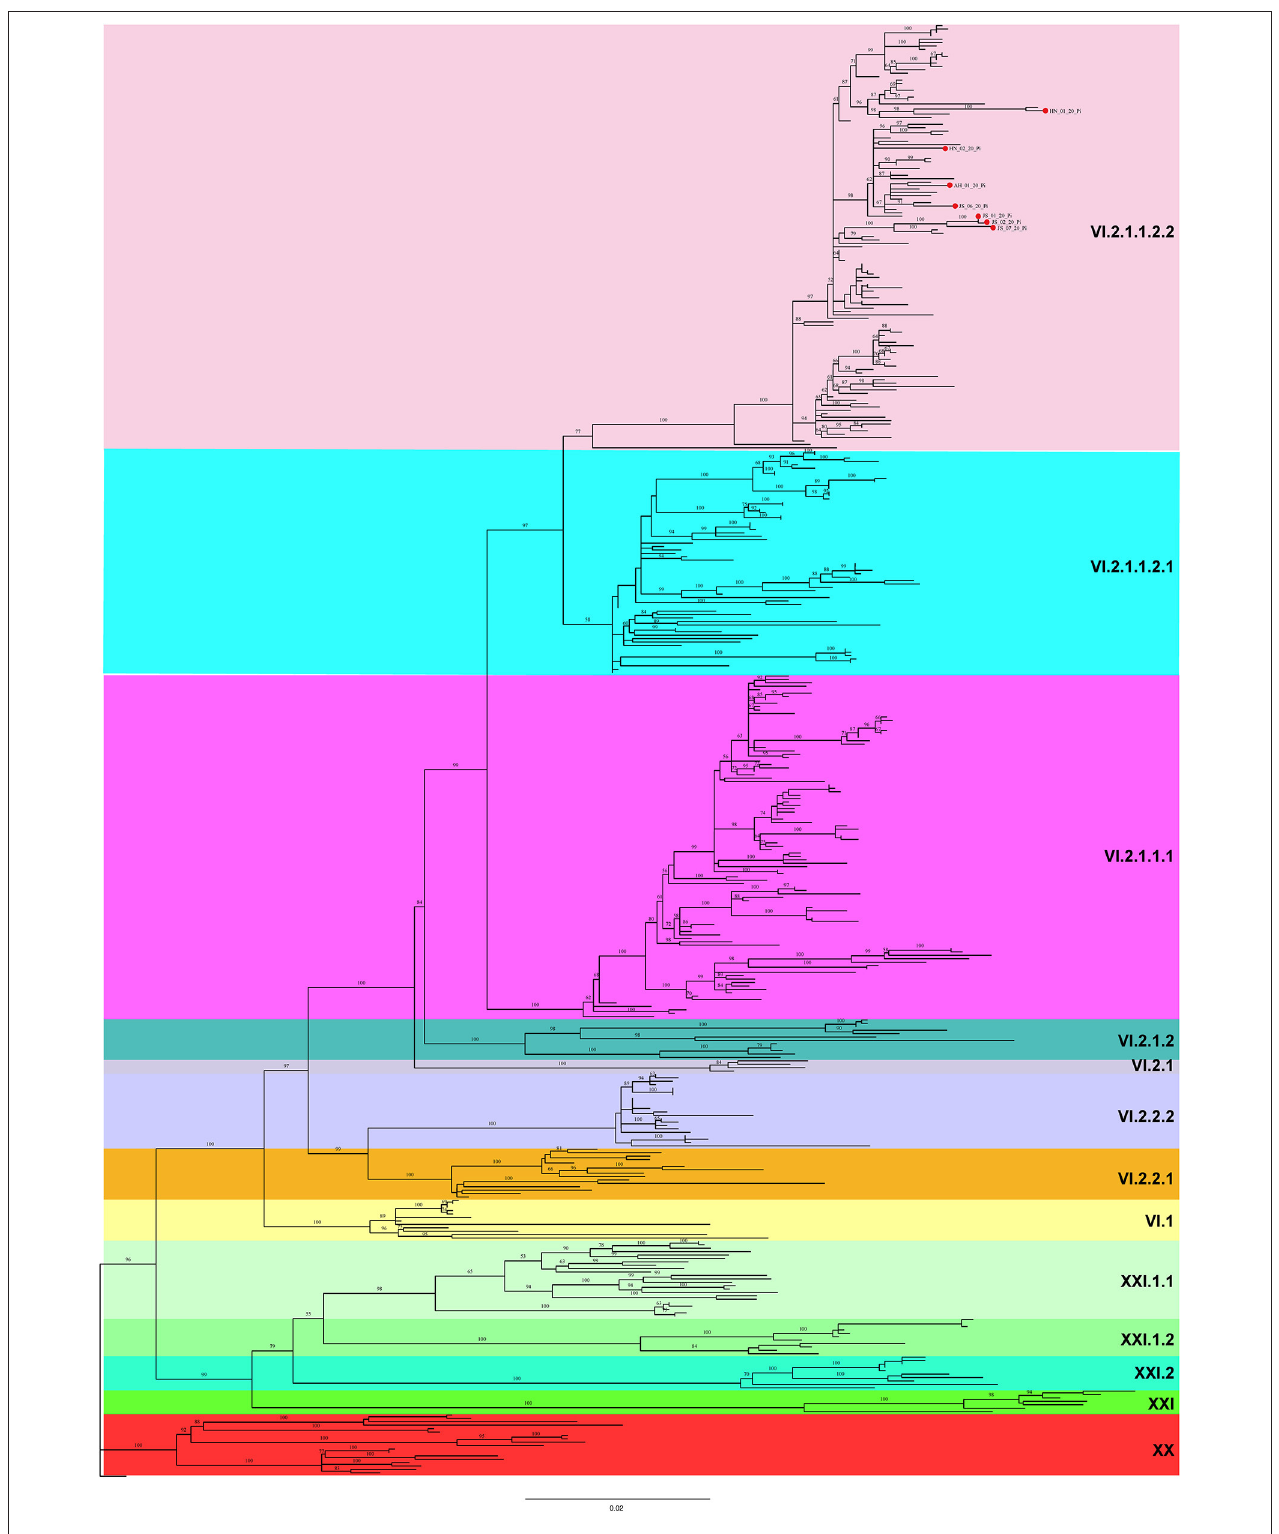
FIGURE 2 | A maximum likelihood (ML) tree based on the complete F gene sequence. The ML tree was constructed using IQ-TREE software with the GTR + F + R4 model (1,000 bootstrap replicates). All 7 PPMV-1 isolates identified in this study are indicated by red solid circles. Different background colors represent different